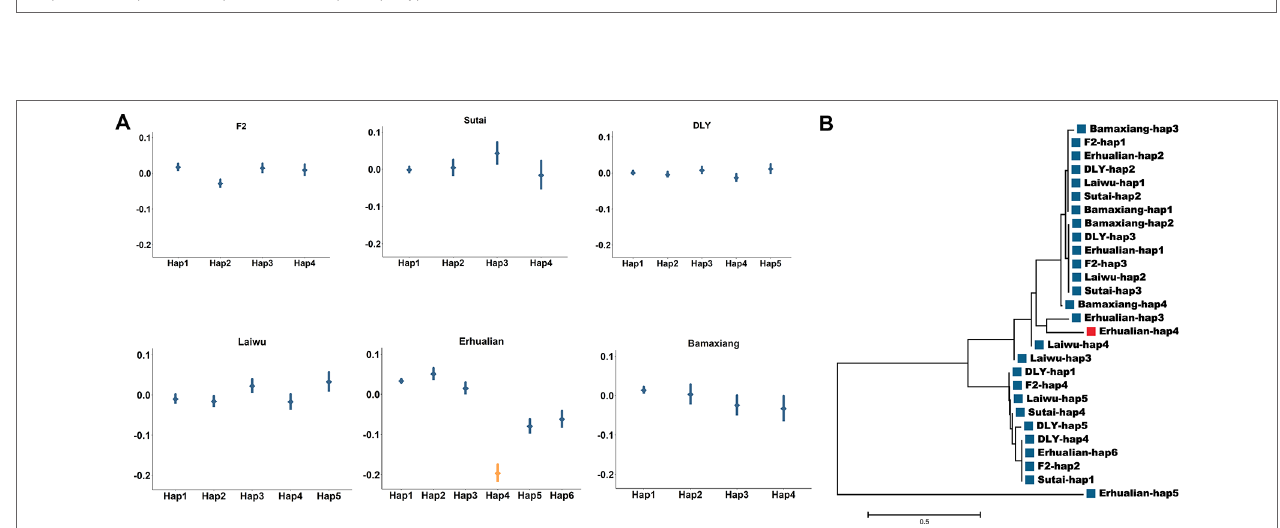
FIGURe 5 | Haplotype analysis of the major QTL for C14:0 on SSC12 in the EHL populations. (A) Distribution of effects of 41 SNP haplotype centered on the lead SNP for C14:0 (1,482,028-1,483,956 bp) identified in Erhualian pigs in the six populations. The points represent the estimates of the haplotype effects. Vertical bars represented the standard errors of the haplotype effect estimates. Haplotype (Hap4) with significant effect of decreasing C14:0 in Erhualian pigs was highlighted by orange color. (B) Neighbor-joining tree for major haplotypes of the QTL on SSC12 across six populations. Haplotype (Erhualian-Hap4) specific to Erhualian pigs is highlighted by red